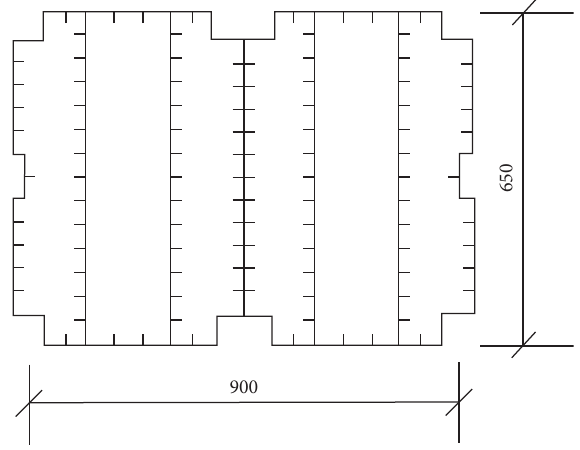
Figure 2: Sectional form of the first section.